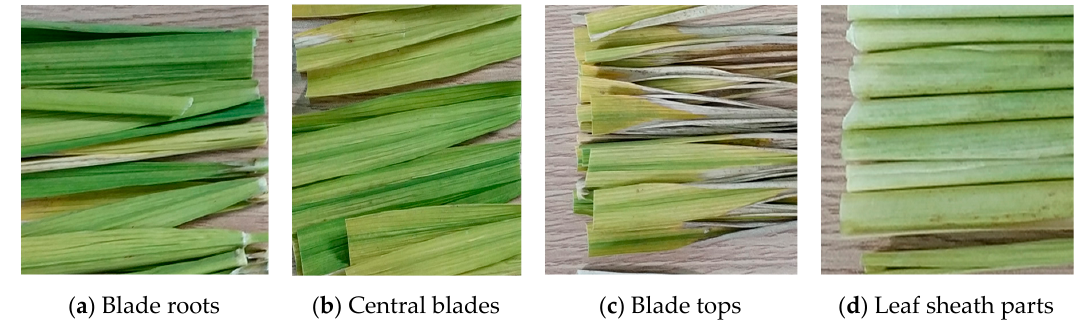
Figure 5. Leaf samples used in this experiment.